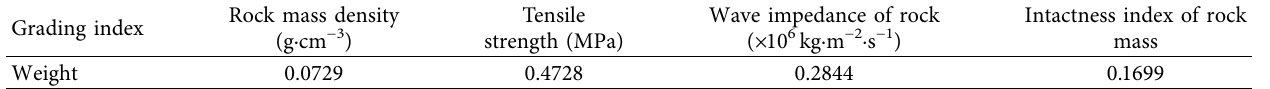
Table 4: Weight obtained by AHP.